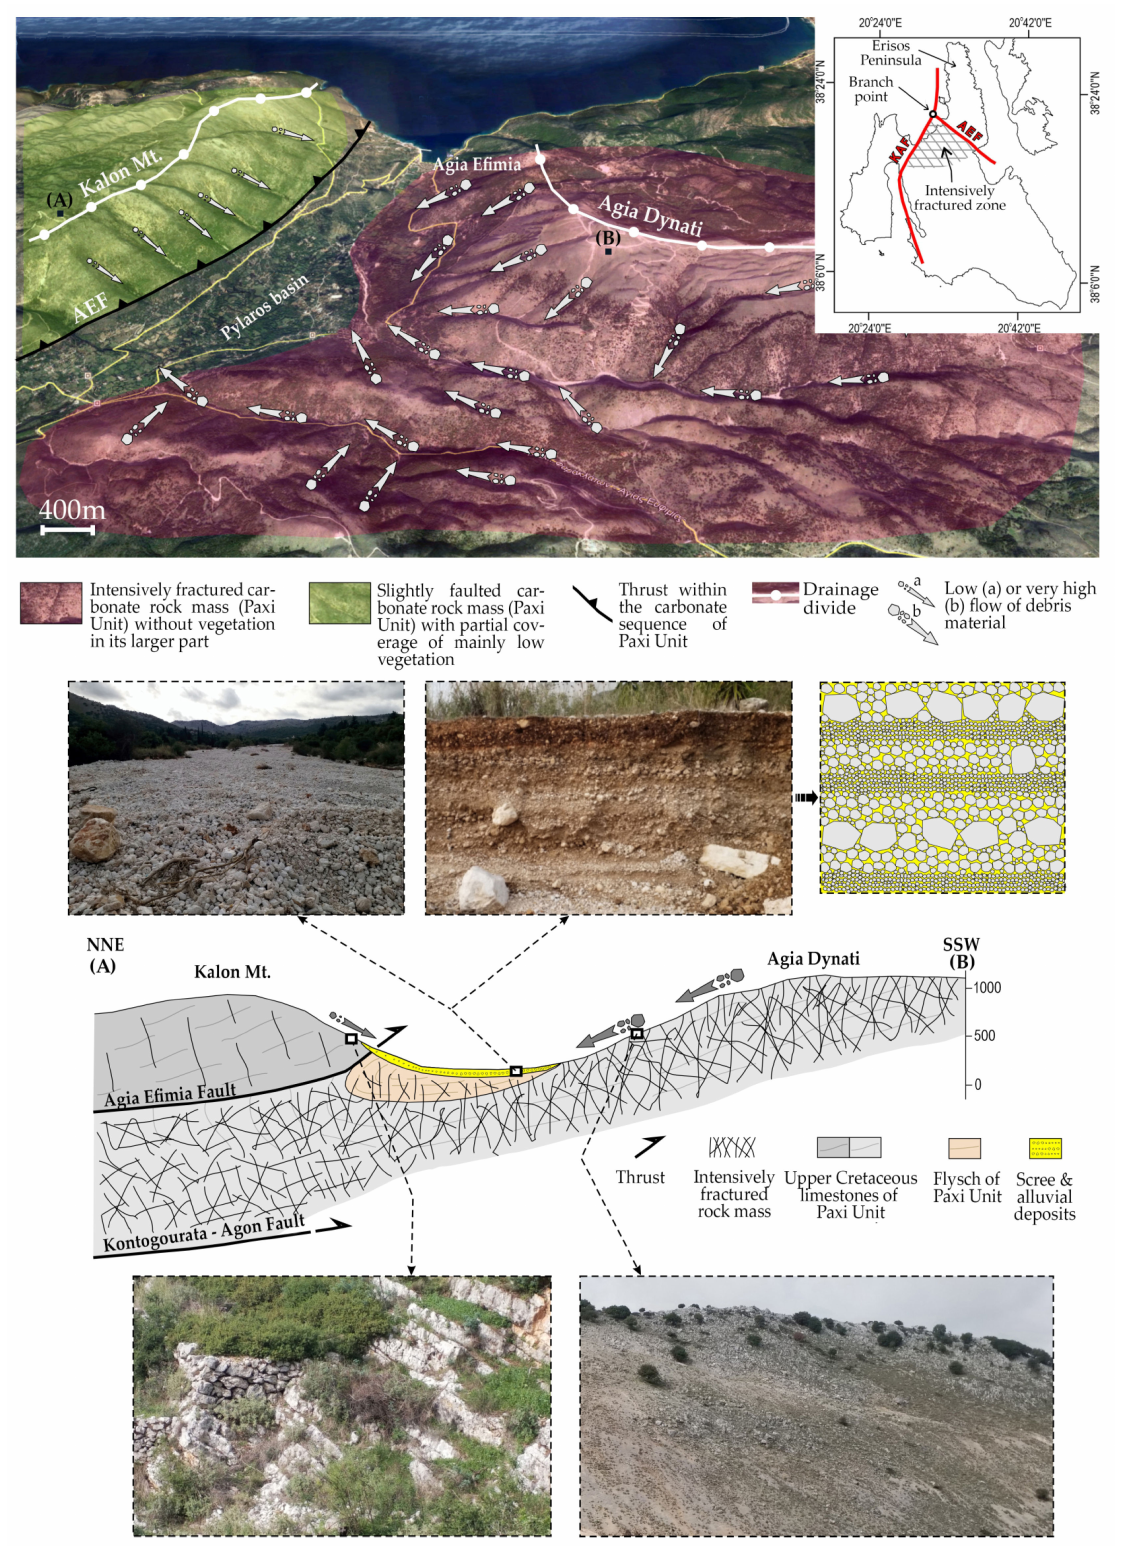
Figure 14. Schematic map and cross-section of Pylaros Basin near Agia Efimia in the northeastern part of Cephalonia, illustrating the geological conditions, as well as characteristic images of the local geological